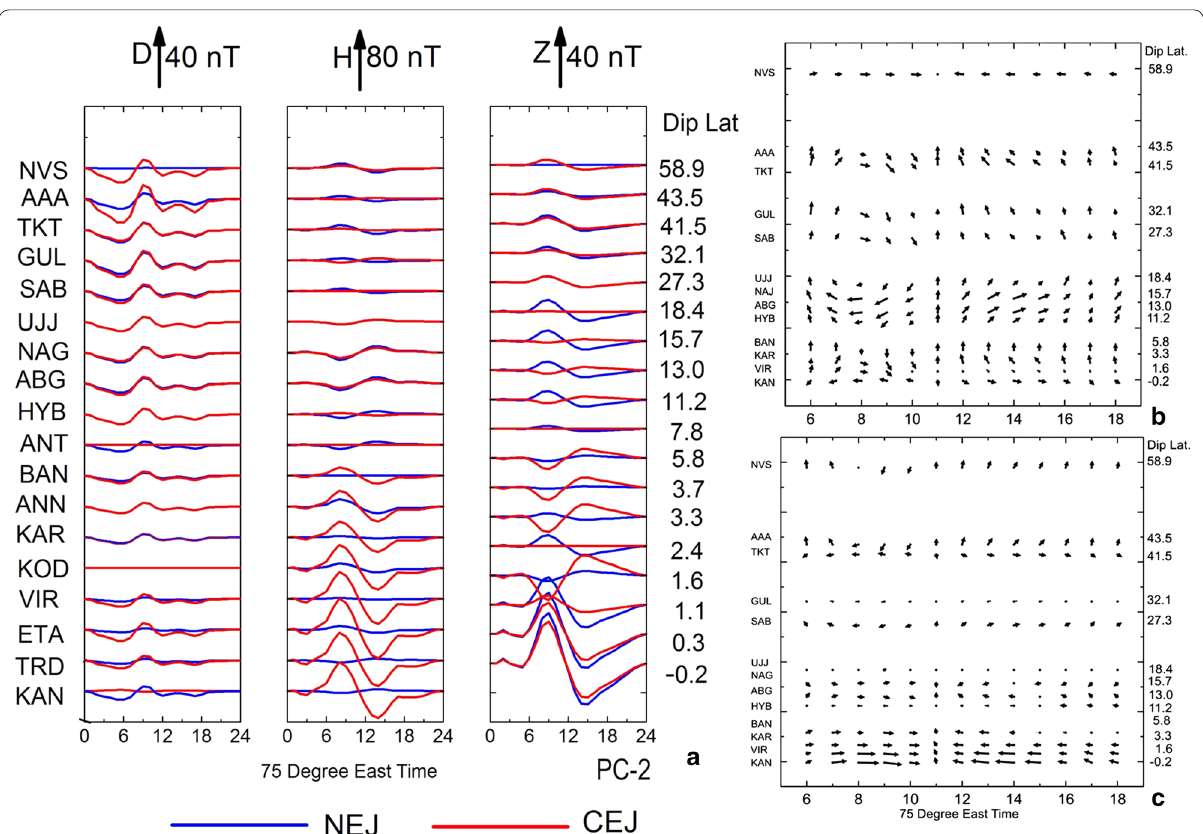
Fig. 3 a Comparison of H-, D-, and Z-components on the NEJ day ( blue curves ) and CEJ day ( red curves ) for PC-2, showing northward and southward fields in the forenoon and afternoon hours at equatorial stations from KAN to BAN, as observed in the H-component for the CEJ day. b Plots of equivalent current vectors on the local time latitude sector for PC-2 during the NEJ day, showing the absence of a clear vortex. c The same as b but for the CEJ